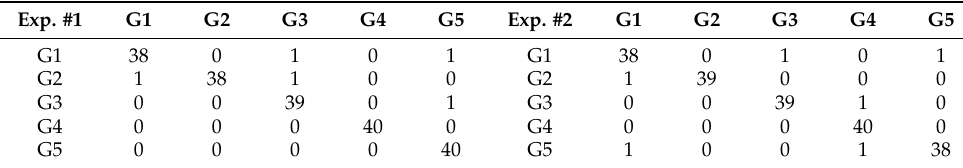
Table 11. Confusion matrices for experimental setups #1 and